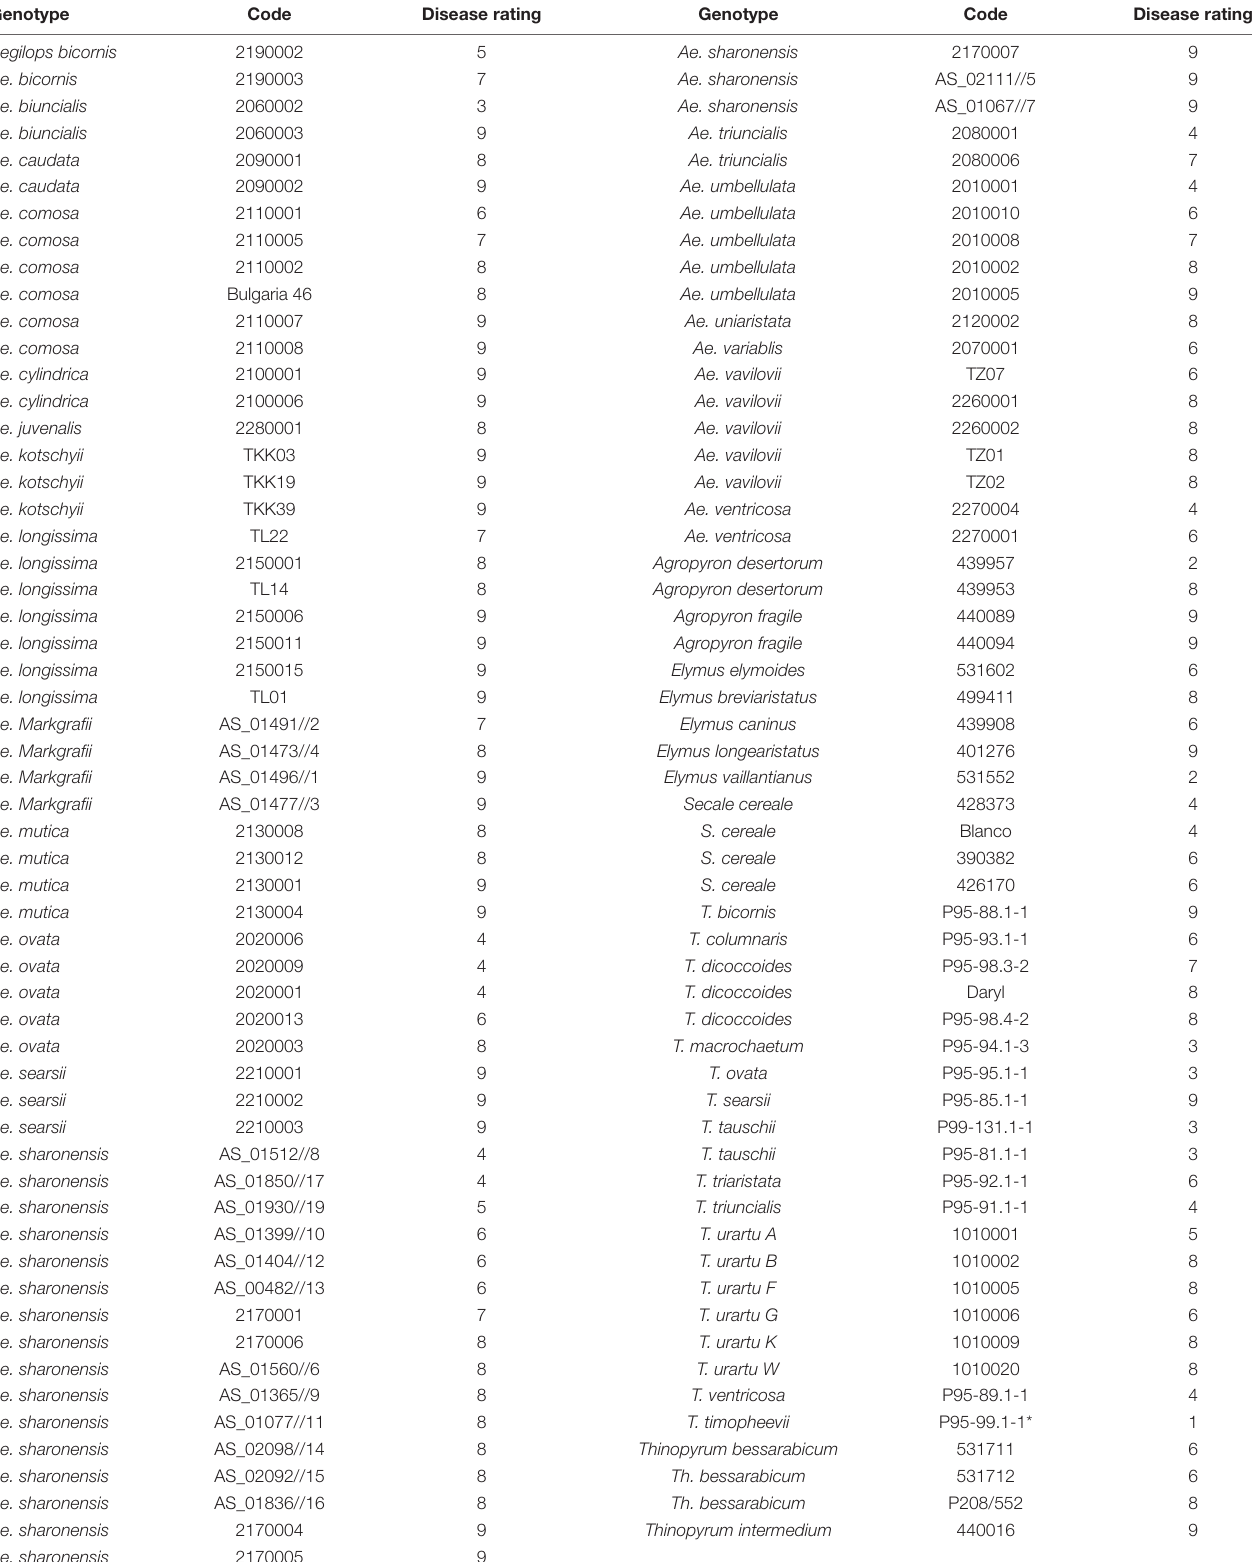
TABLE 1 | Fusarium head blight disease rating of 113 wild grass species/accessions of wheat relatives following spray inoculation with conidia of F. graminearum. Genotype Code Disease